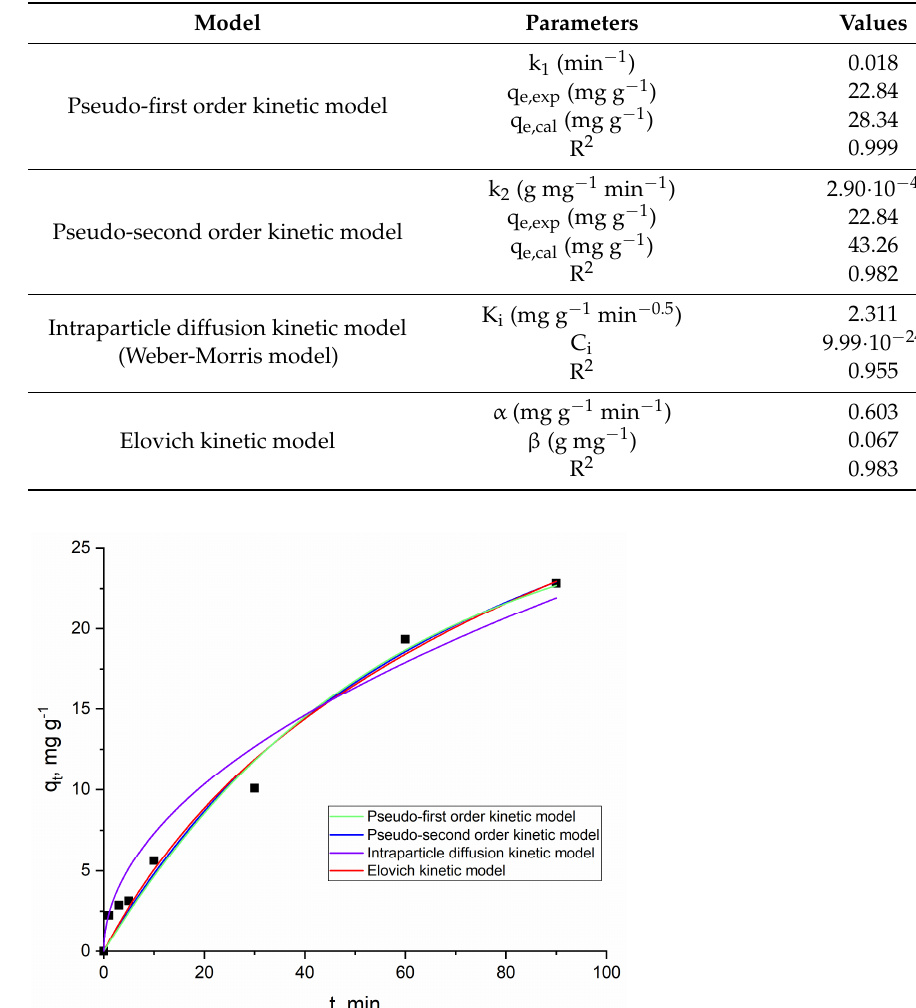
Figure 5. Non–linear kinetic models for copper ions biosorption onto chicken eggshells.